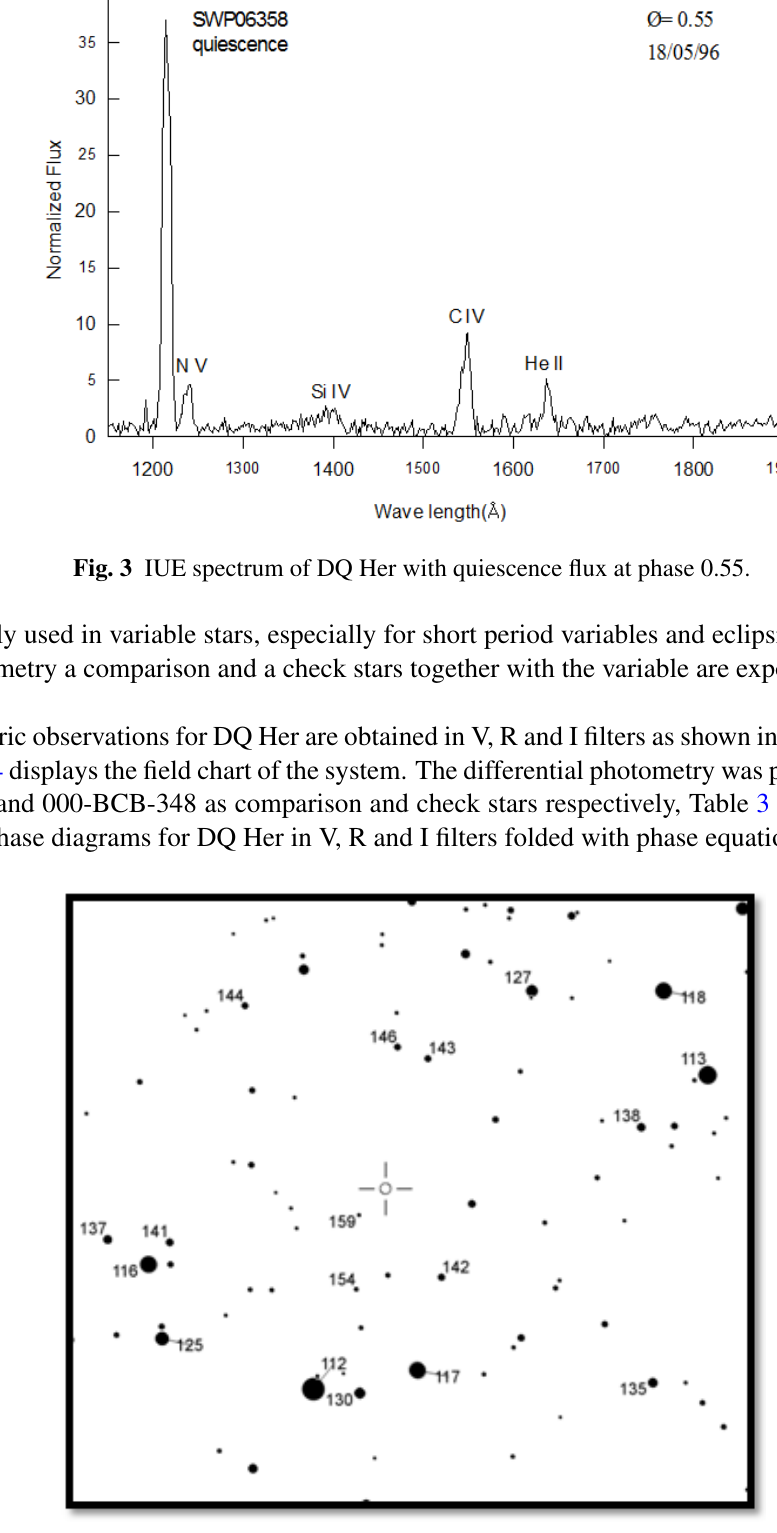
Fig. 4 The field chart of the DQ